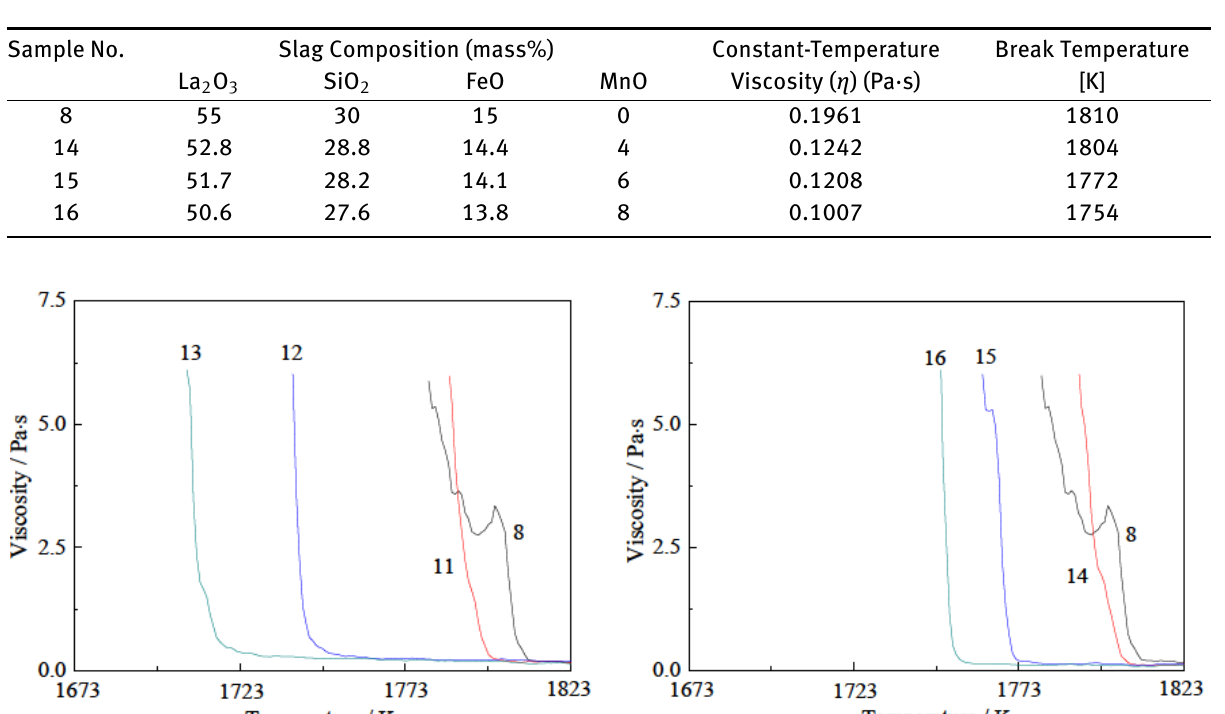
formed low-melting compounds CaMnSiO with CaO and SiO